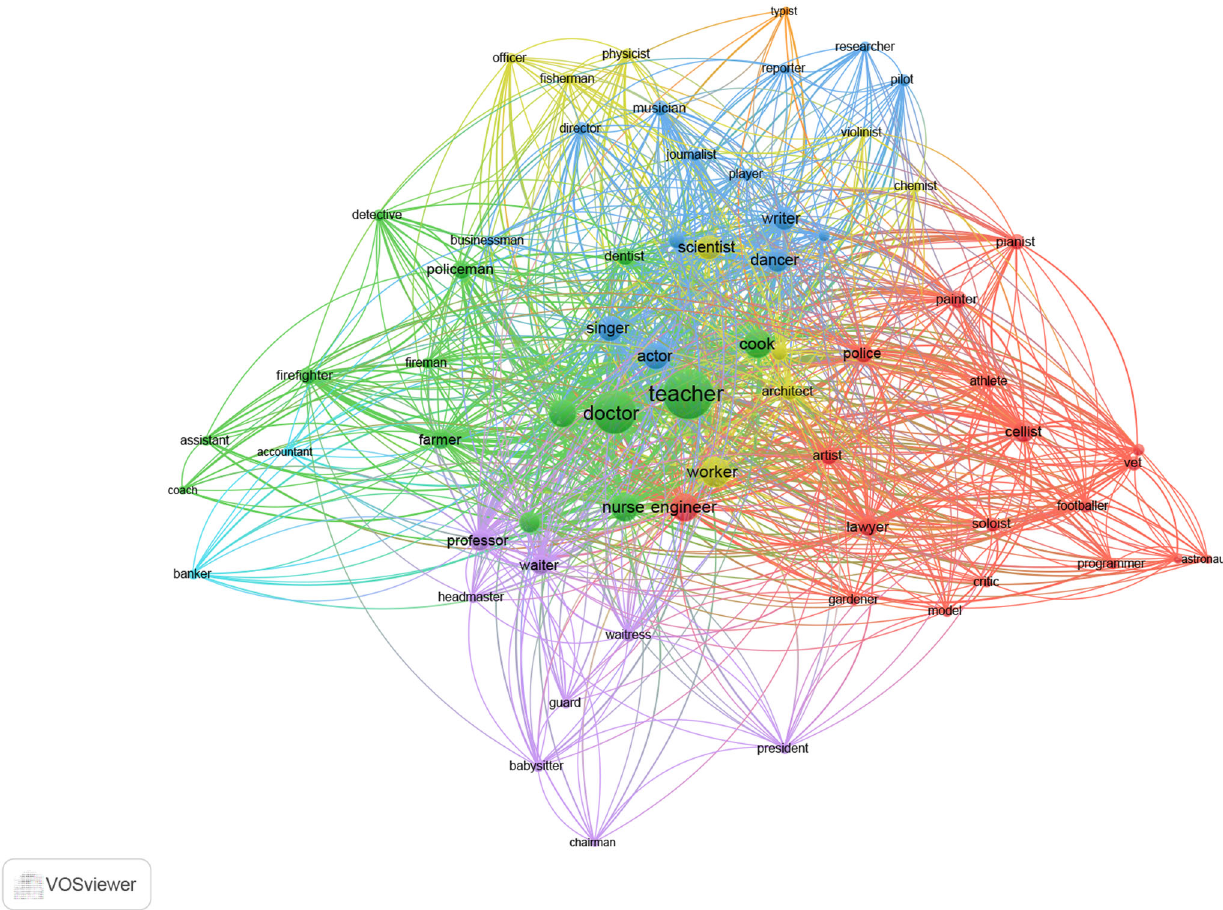
Fig. 3 The L2 lexical-semantic networks of the undergraduates (nodes ’ frequency above 2). The size of nodes represents the number of links and the color of links signi fi es